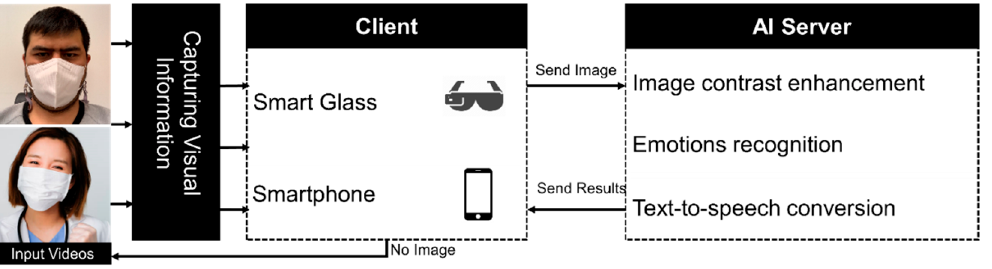
Figure 3. The general structure of the client-server